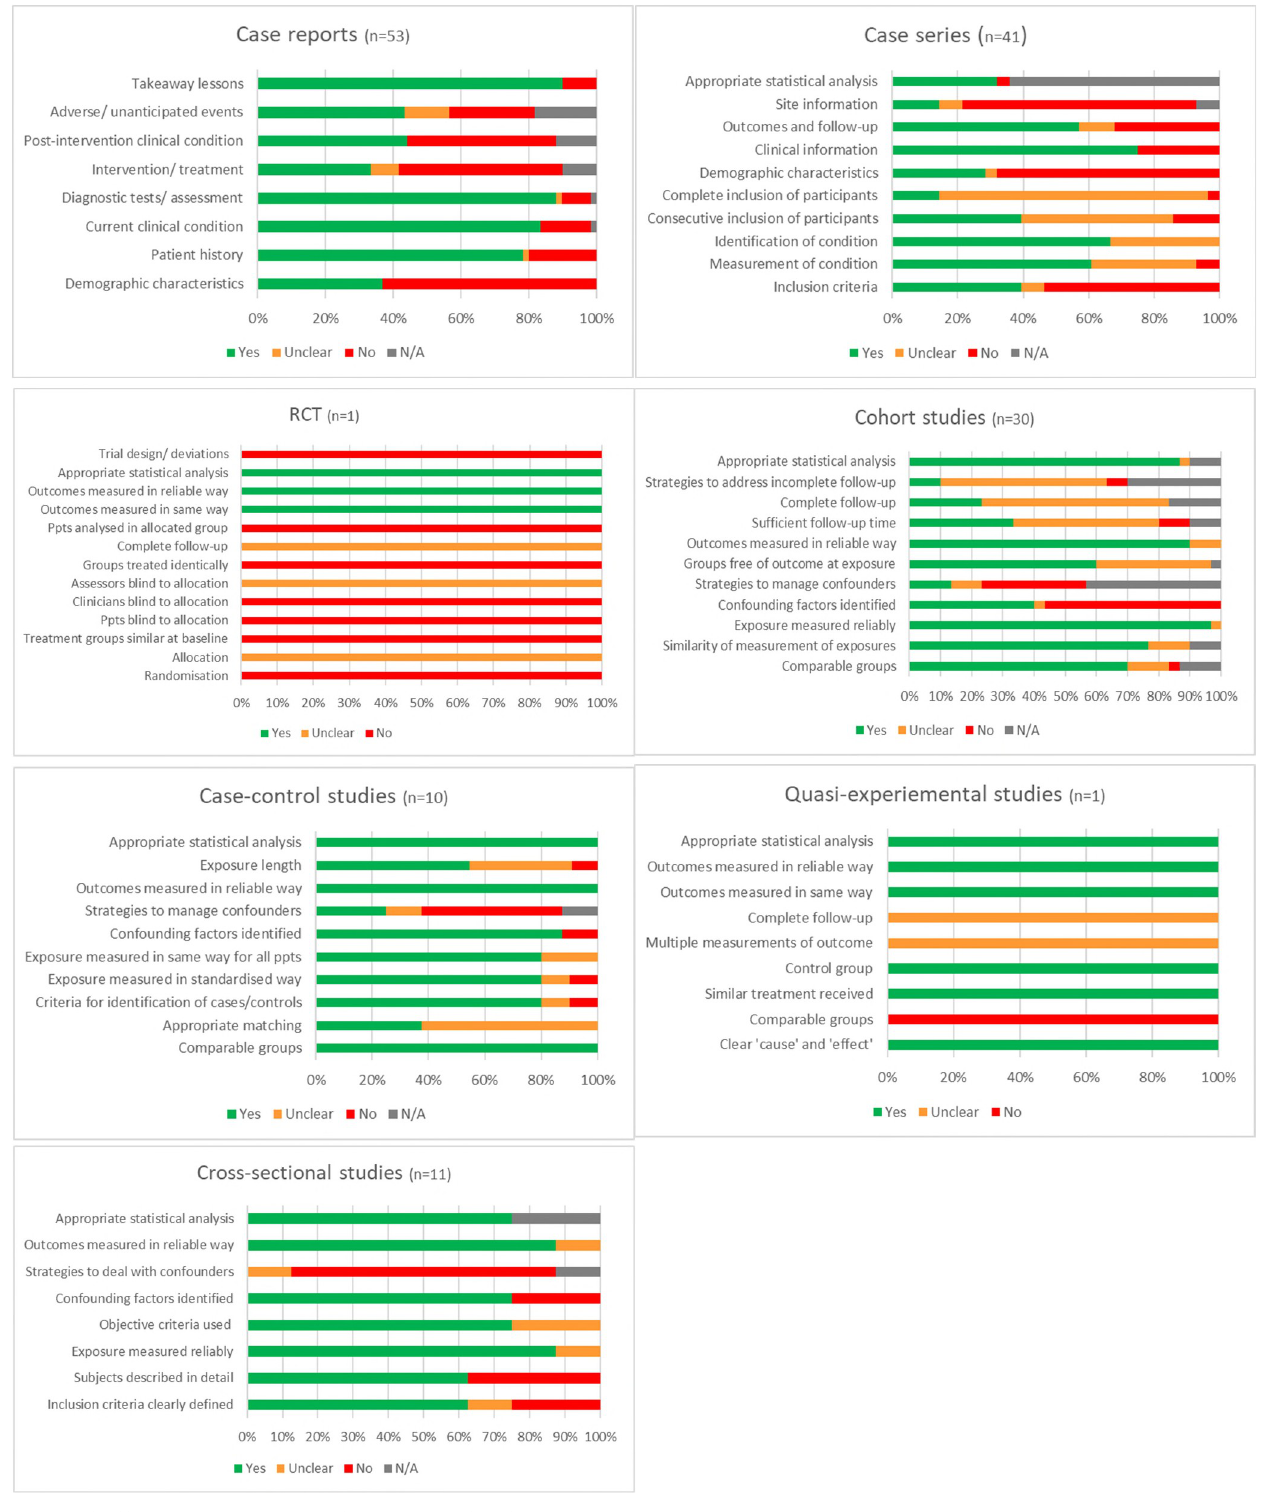
Fig 3. Risk of bias assessment summary by outcome and study type.